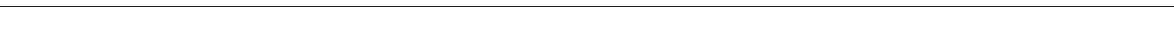
Fig. 1 Three-dimensional morphology of astrocytes in layers I – VI of the mouse somatosensory cortex as revealed by visualization of microtubule and whole-cell structures. a 3D reconstruction of astrocyte morphology in the Glast-EMTB-GFP mouse brain (P60) rendered transparent by the CUBIC technique. 3D structures and traces are shown in the left panels, and individual traces in the right. CC, corpus callosum. Scale bars, 250 μ m (left panels), 50 μ m (right panels). b Representative confocal image of sparsely labeled astrocytes in Glast-EMTB-GFP;Glast-CreER T2 ;Rosa-CAG-LSL-tdTomato mice (P65) injected with a low dose of tamoxifen at P60 (left), and representative 3D projection images of astrocytes in each layer (right). Arrowhead indicates GFP + tdTomato + cell. Scale bars, 250 μ m (left panel), 50 μ m (right panels). c , d Quanti fi cation of territorial volume ( c ) and the angle of orientation relative to the brain surface ( d ) for astrocytes in each layer. The data are shown for 116 cells from fi ve brains, with the red bars indicating median values. * P < 0.05, ** P < 0.01, *** P < 0.001 (one-way ANOVA followed by Bonferroni ’ s test). e 3D Sholl analysis for microtubule structure of sparsely labeled individual astrocytes in layers II/III and VI of Glast-EMTB-GFP;Glast-CreER T2 ;Rosa-CAG-LSL-tdTomato mice injected with a low dose of tamoxifen at P60. The data are means (layer II/III astrocytes, n = 27 cells from fi ve brains; layer VI astrocytes, n = 16 cells from fi ve brains). * P < 0.05, ** P < 0.01, *** P < 0.001 versus corresponding values for layer VI astrocytes (two-way ANOVA followed by Bonferroni ’ s